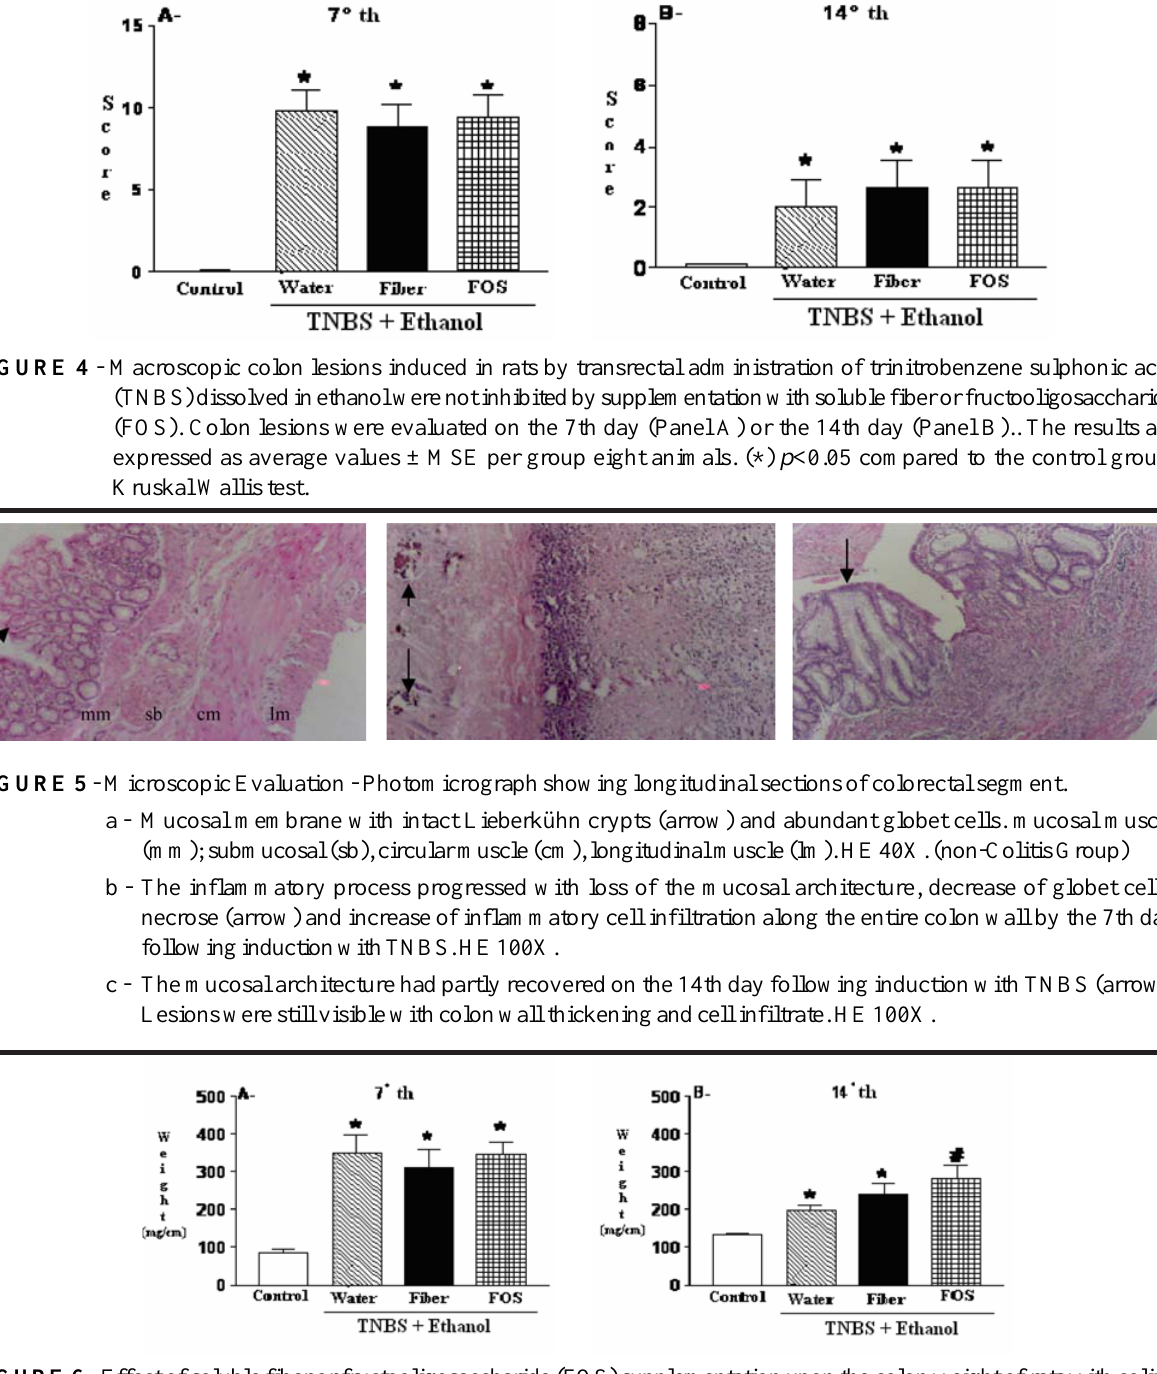
FIGURE 6 - Effect of soluble fiber or fructooligosaccharide (FOS) supplementation upon the colon weight of rats with colitis induced by transrectal administration of trinitrobenzene sulphonic acid (TNBS) dissolved in ethanol . The colon weight/length ratio was determined on the 7th day (Panel A) or the 14th day (Panel B). The results are expressed as average values ± MSE per group eight animals. (*) p <0.05 compared to the control group. Kruskal Wallis